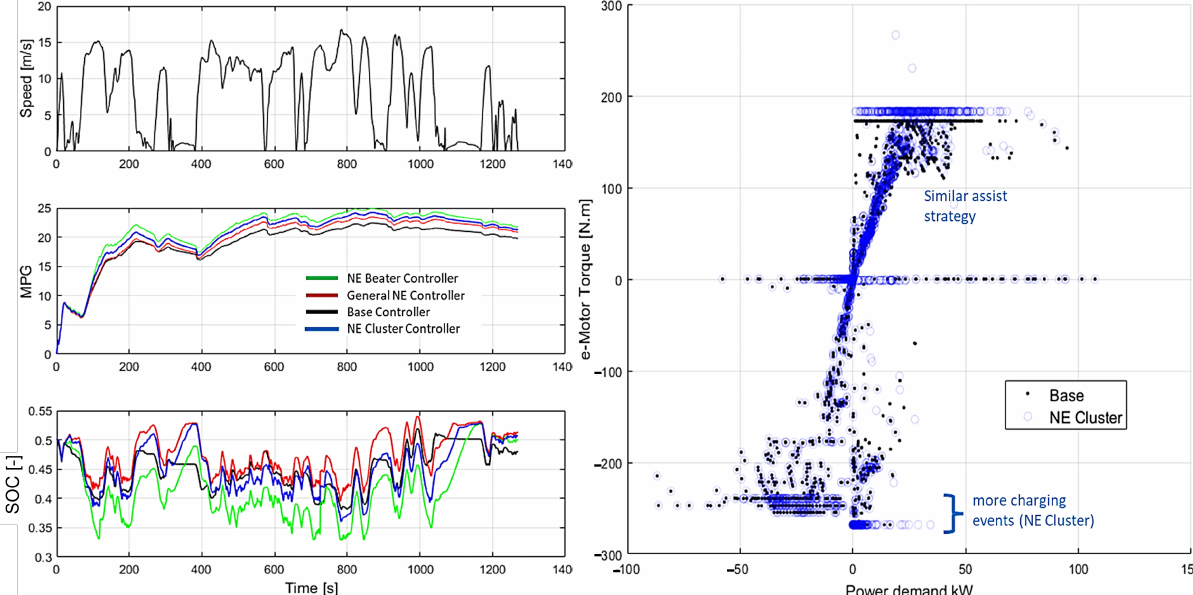
Figure 14. HEV operation comparison between the four hybrid controllers. The charging and assist strategy is highlighted for the base and NE Cluster controllers on the